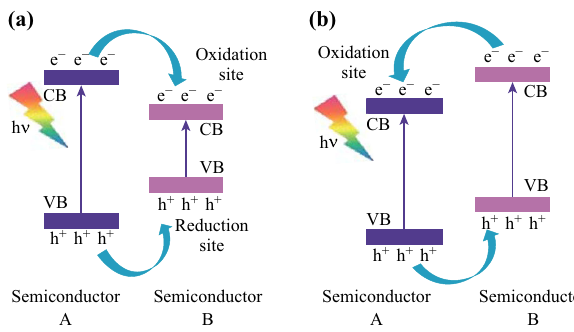
Fig. 9 Semiconducting heterojunctions with a type I and b type II band alignments. Reproduced with permission from Ref. [215]